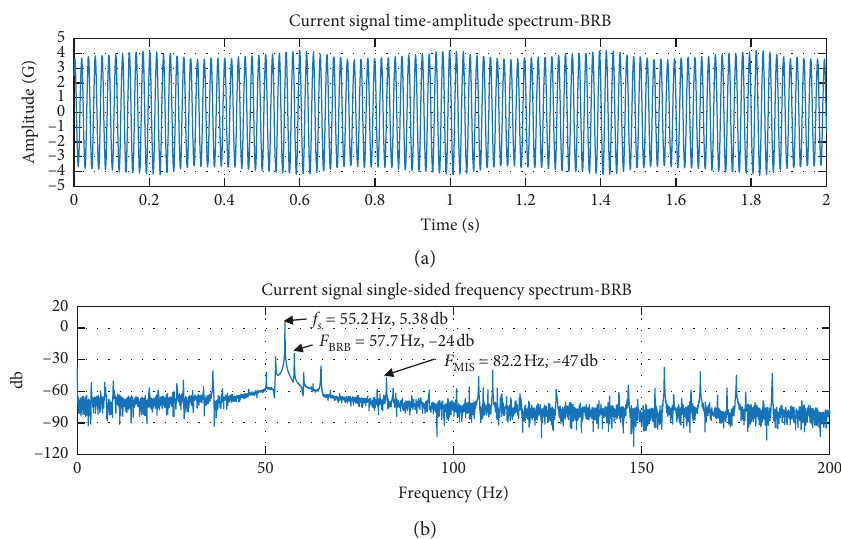
Figure 15: (a) Time response and (b) Fourier spectrum of the current signal under the broken rotor bar condition. WPD coefficient of 55–57.5Hz